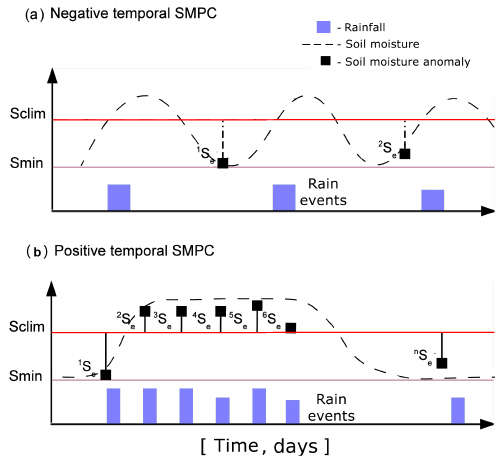
Figure 12. Conceptual diagrams of the relationship between daily rainfall occurrence and the surface moisture variability associated to it, in time, as representative of (a) West Africa and temporally negative SMPC and (b) central and northern Europe and positive temporal